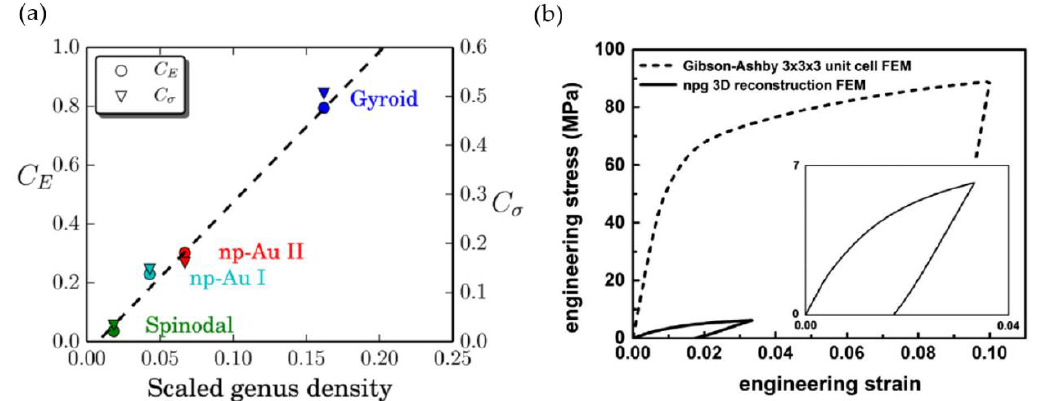
Figure 17. ( a ) Leading constants in the Gibson–Ashby scaling laws predicted for constant solid fractions depend linearly on the scaled genus density, reprinted from [18] with permission of Elsevier and ( b ) the stress–strain response of the np-Au reconstruction compared to the Gibson–Ashby model of same solid fraction [19], reprinted by permission of Taylor & Francis Ltd.